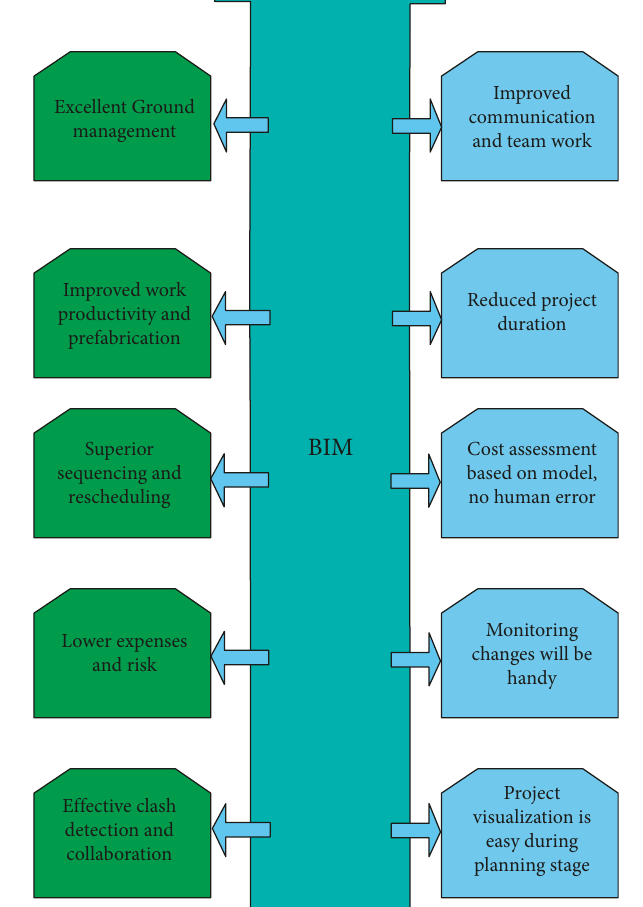
Figure 8: Specific impact of utilizing BIM in the industry.